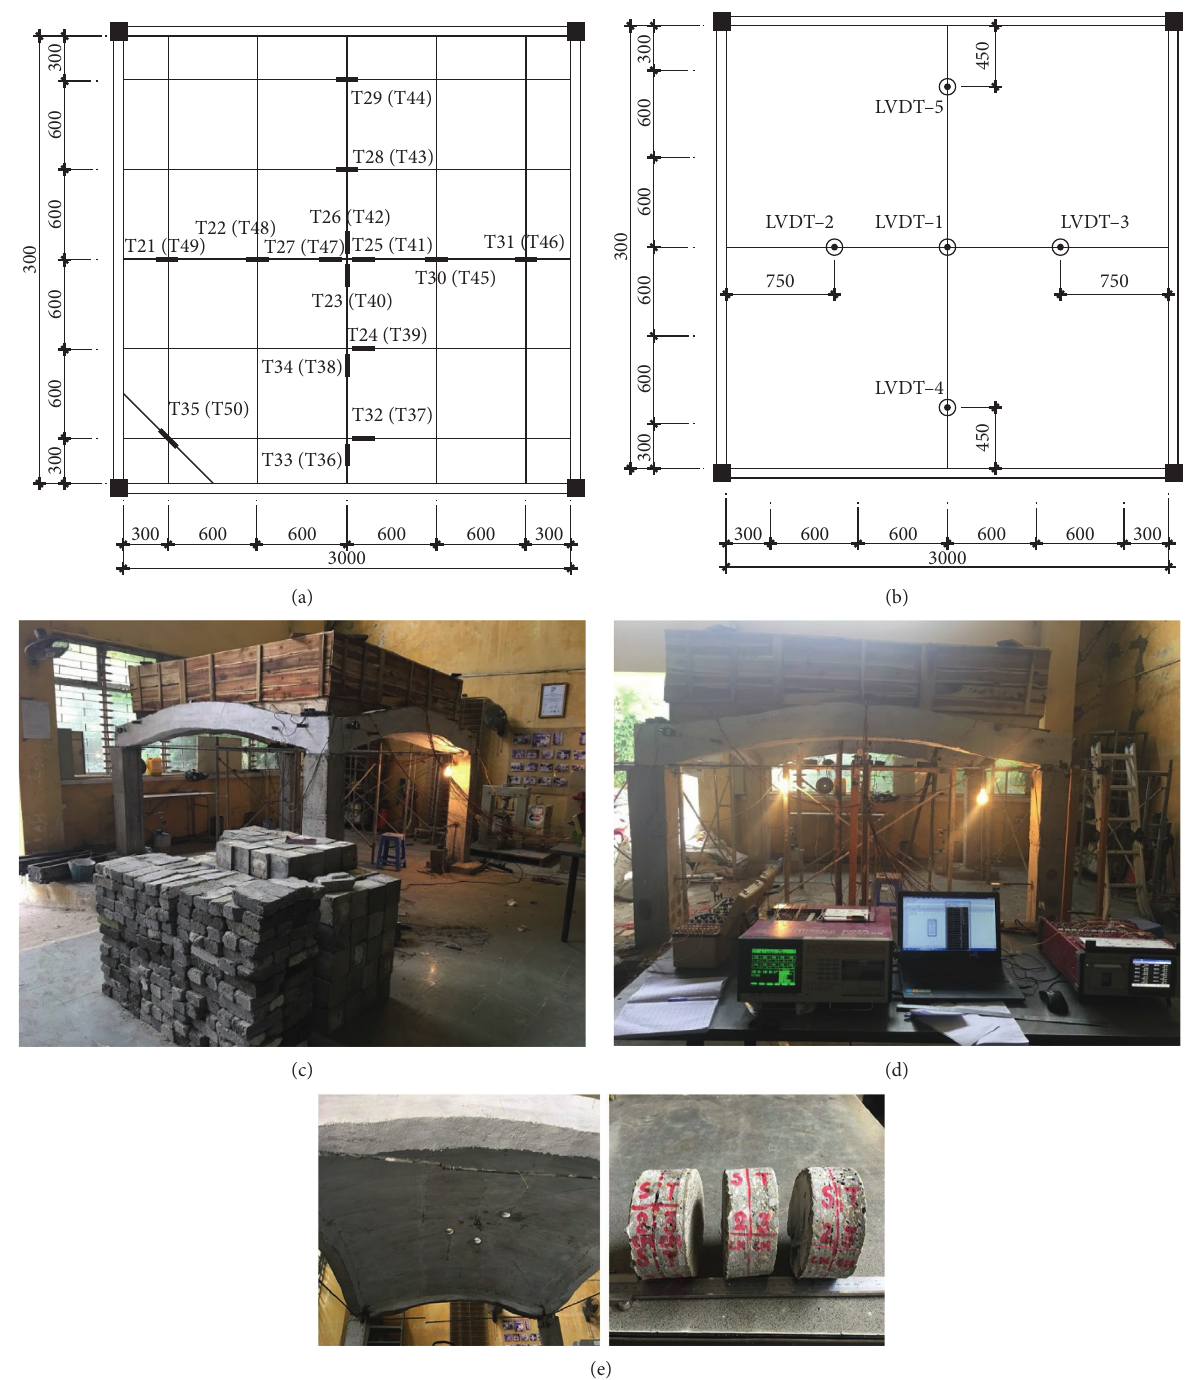
Figure 3: Installation of measuring equipment and loading on the shell. (a) Installation diagram of strain gauges (tensiometers). (b) Installation diagram of LVDTs. (c) Load the shell with small concrete blocks. (d) Connect the measuring equipment to the computers. (e) Check the thickness of the